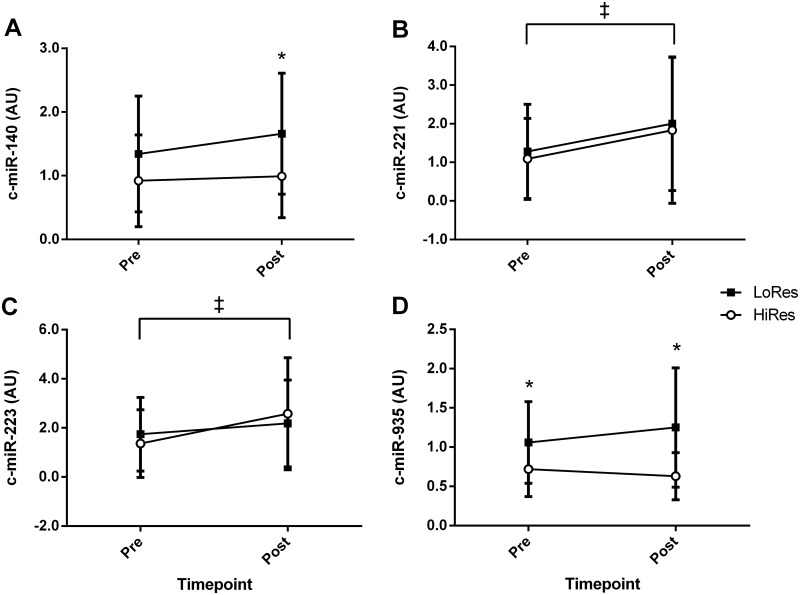
Plasma c-miR abundance prior to and after a 16 week diet and exercise weight loss intervention for high responders (HiRes, n = 22) and low responders (LoRes, n = 18) A: c-miR-140, B: c-miR-221; C: c-miR-223, and D: c-miR-935; data are mean ± SD; P<0.05: ‡ difference pre vs post, * difference HiRes vs LoRes.